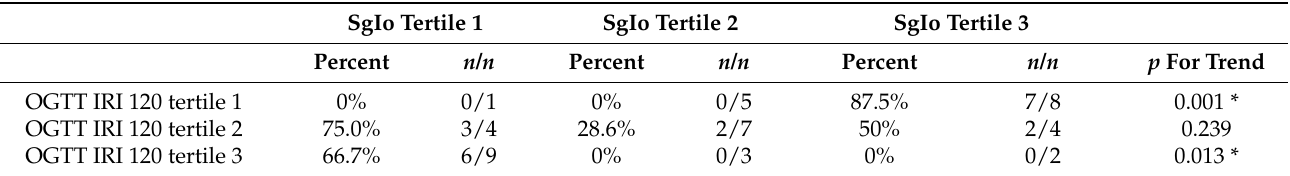
Table 5. The proportions of the participants with SRH in the SgIo tertile categories according to OGTT IRI 120 tertile